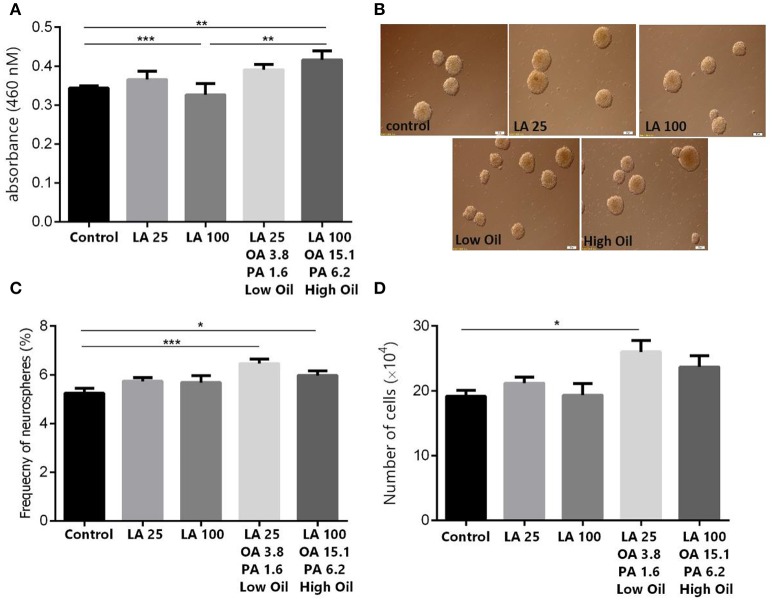
Effect of safflower seed oil on cell viability and neurosphere formation of NSCs. (A) Cell proliferation quantified by measuring the change in the abundance of viable cells. Neurospheres from eNSC were incubated in LA or safflower seed oil for 48 h. MTT was added to each well at 4 h before the end of the incubation. The absorbance was measured at 460 nm. Results are representatives of 5 separate experiments and reported as mean ± SEM. (B) Representative captures of neurospheres in different groups. Scale bars: 100 μm. (C) Single eNSCs at a density of 500 cells/well were cultured in normal growth medium containing DMEM/F12 supplemented with FGF for 6 days to form neurospheres. The frequency of neurosphere formation was calculated by counting neurospheres with >50 μM diameter. (D) Cell counts obtained from neurospheres. Data are expressed as Mean ± SEM of 15 independent experiments. A one-way analysis of variance (ANOVA) following Tukey post-test was performed to compare the mean values. *p < 0.05; **p < 0.01; and ***p < 0.001 were considered significant.